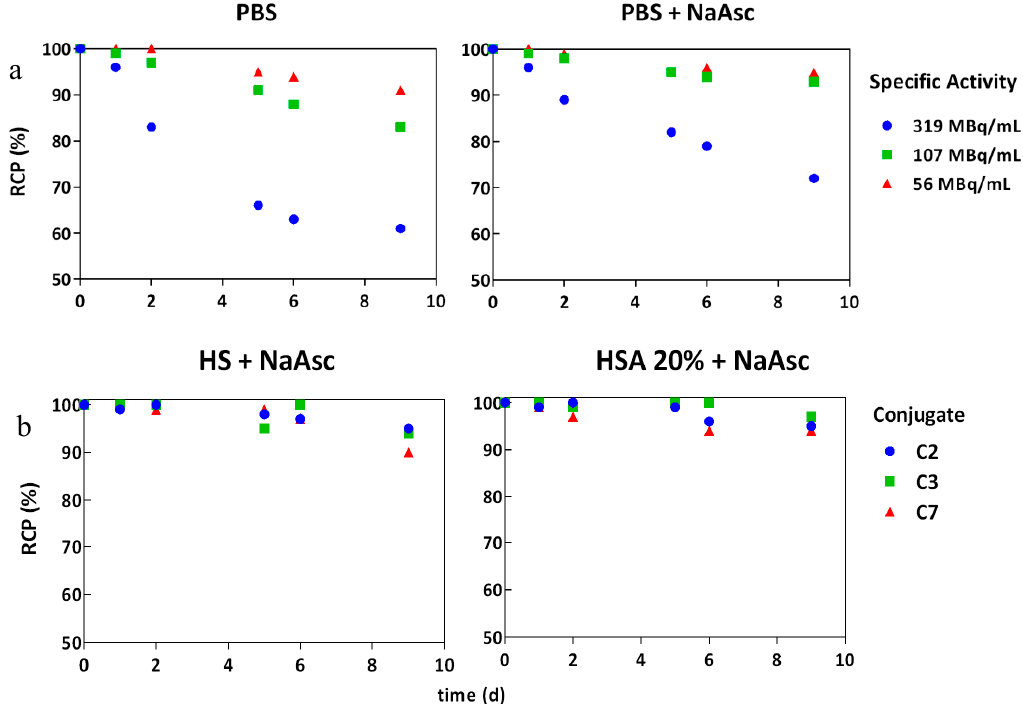
Figure 4. In vitro stability of [ 177 Lu]DOTA(SCN)-cG250 in the presence of NaAsc by TLC: ( a ) C3 radioconstructs at different activity concentrations without and with NaAsc respectively and ( b ) C2, C3, and C7 radioconstructs (2 MBq/ μ g) in human serum and HSA 20% in the presence of NaAsc.